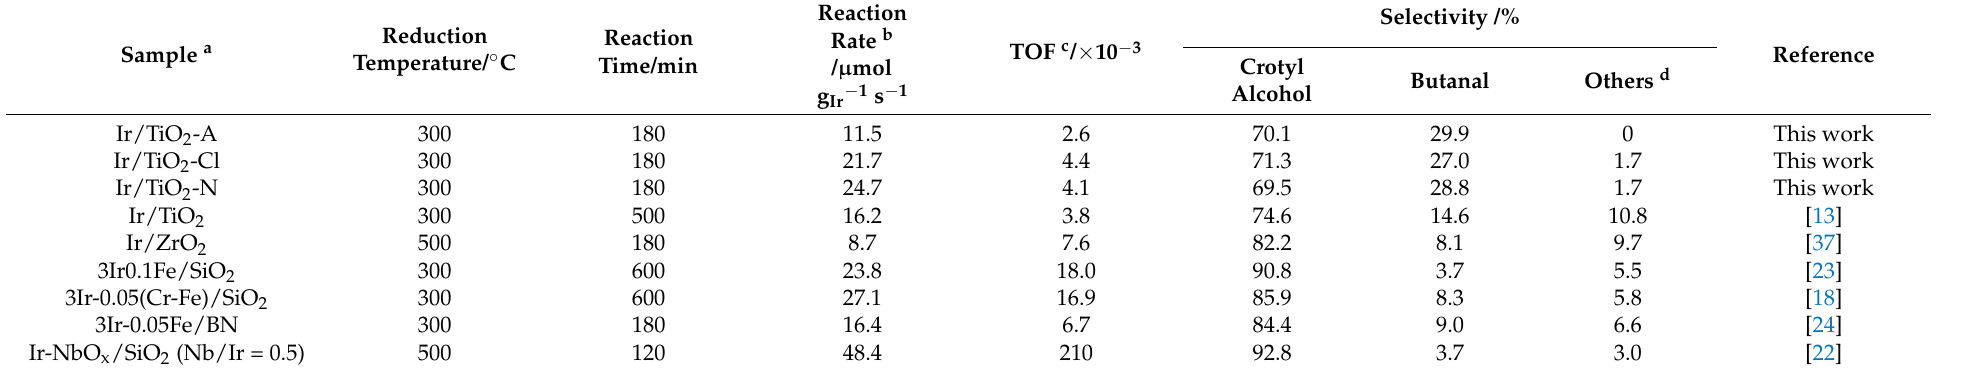
Table 2. Summary of reaction results over various Ir-based